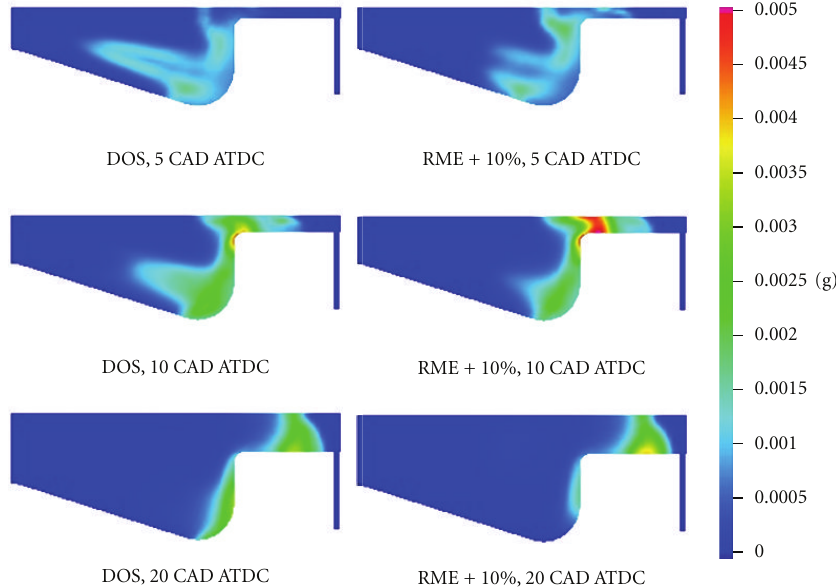
Figure 12: In-cylinder NO concentration distribution for the Volvo D12C diesel engine fuelled by DOS and RME+ 10% at 5, 10, 20 CAD ATDC without EGR.